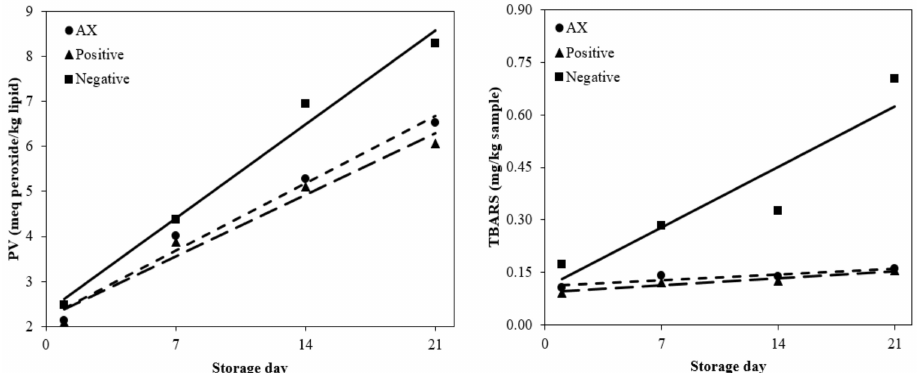
Figure 1. Effects of antioxidants on lipid oxidation of emulsified sausage. The solid lines are for the negative control, the large dashed line for the positive control, and the small dashed line for AX. Negative: without antioxidant; Positive: with 200 mg/kg mixture of BHT and BHA (1:1, w / w ); AX, with 400 mg/kg astaxanthin.